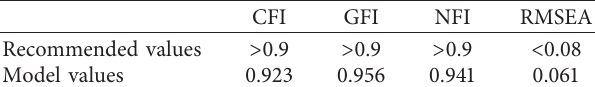
Table 6: Model fit summary.